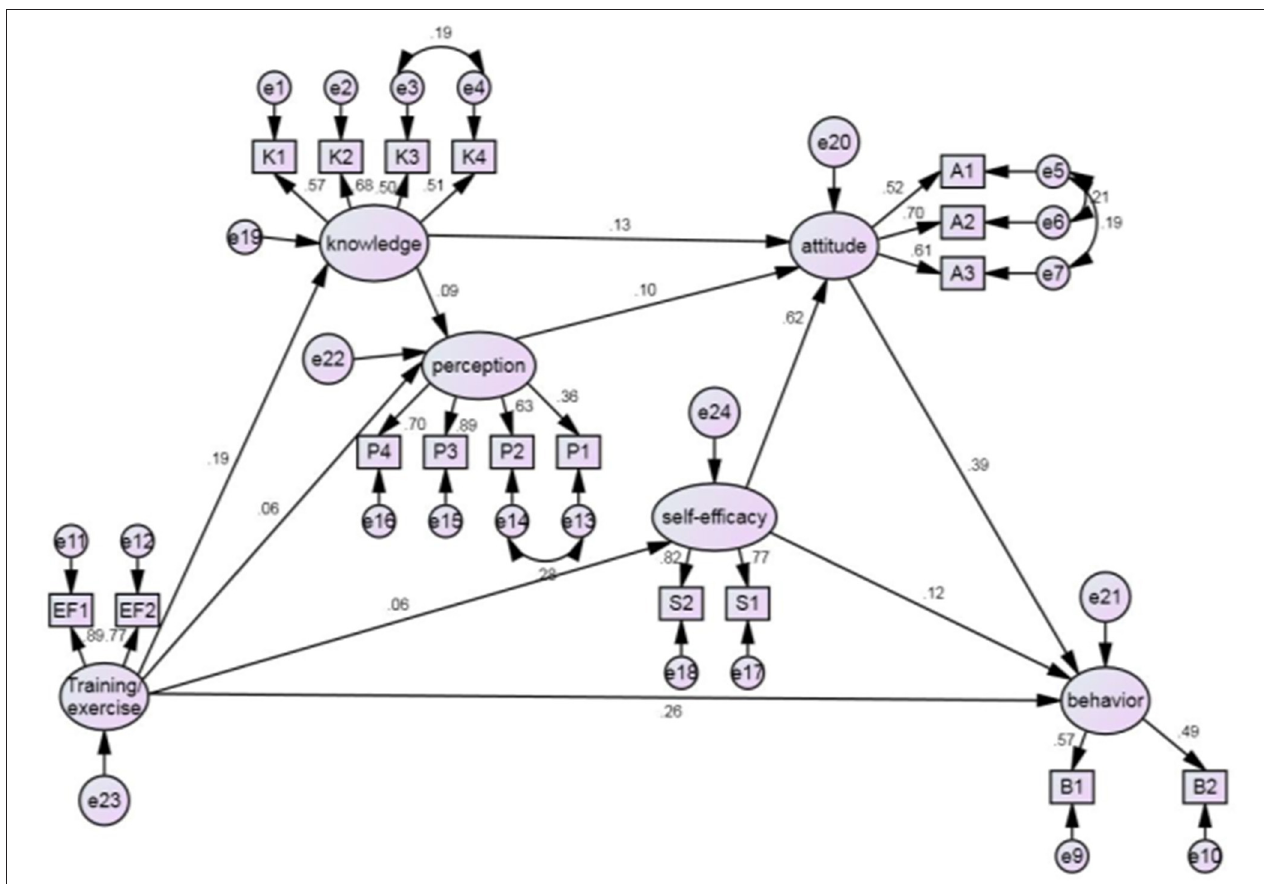
FIGURE 2 | The modified emergency preparedness behavior